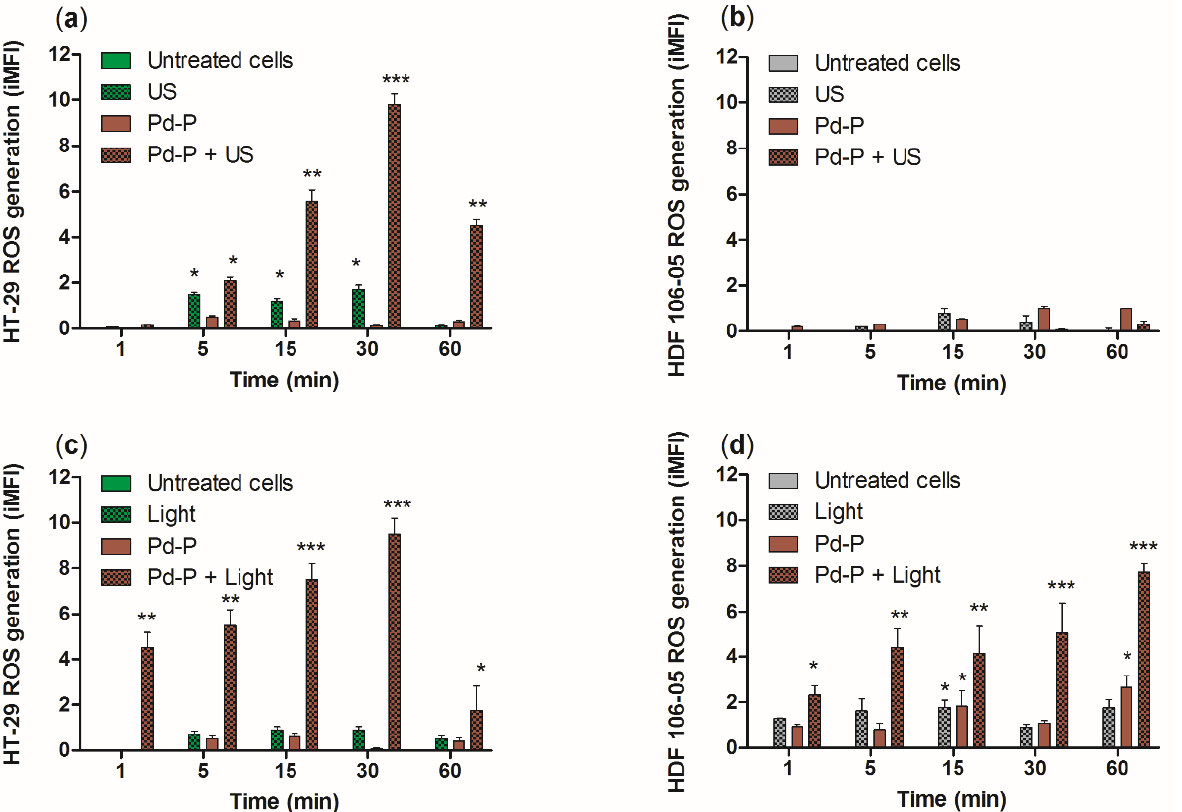
Figure 6. Reactive oxygen species production after sonodynamic or photodynamic treatment. HT-29 ( a ) and ( c ) and HDF 106-05 ( b ) and ( d ) cells were incubated for 24 h with 500 μM Pd-P and then exposed to US (1.5 W/cm 2 at 1.866 MHz, for 5 min) or to light (15 mW/cm 2 at 405 nm, for 5 min) at the appropriate wavelength (405 nm). ROS levels were determined at different time points after each treatment (1, 5, 15, 30 and 60 min) with 2′, 7′-dichlorofluorescein diacetate (DCF-DA) assay using flow cytometry. Results are expressed as the integrated mean fluorescence (iMFI) ratio. Statistically significant dif- ference versus untreated cells: * p < 0.05, ** p < 0.01, *** p < 0.001.